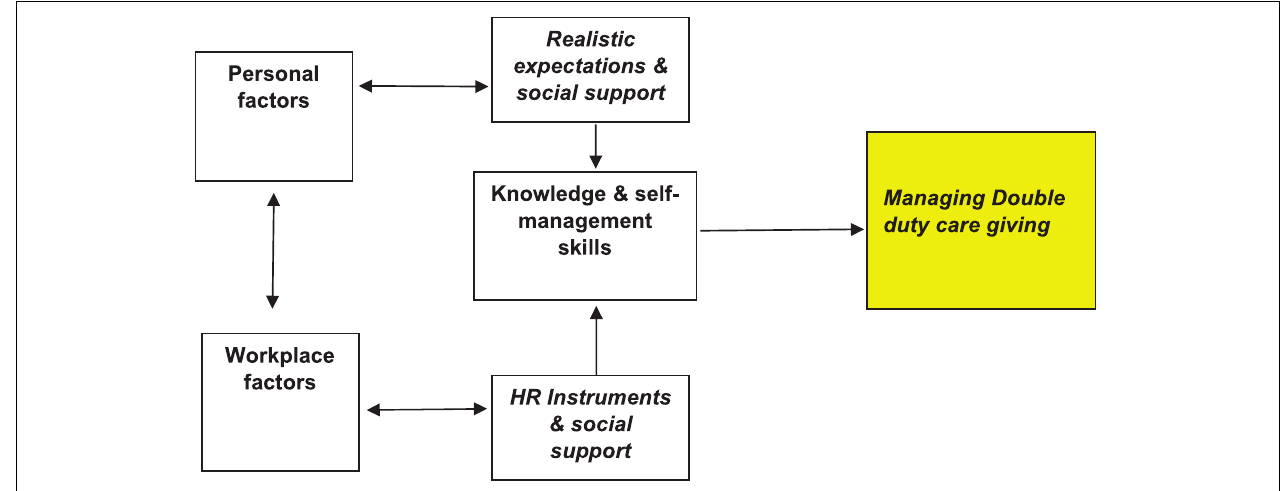
FIGURE 2 | Conceptual model for future research on the sustainable employability of double duty caregivers. TABLE 2 | Adapted HRM bundles for workers with double duty care tasks. Bundle HRM practice Development Maintenance Utilization